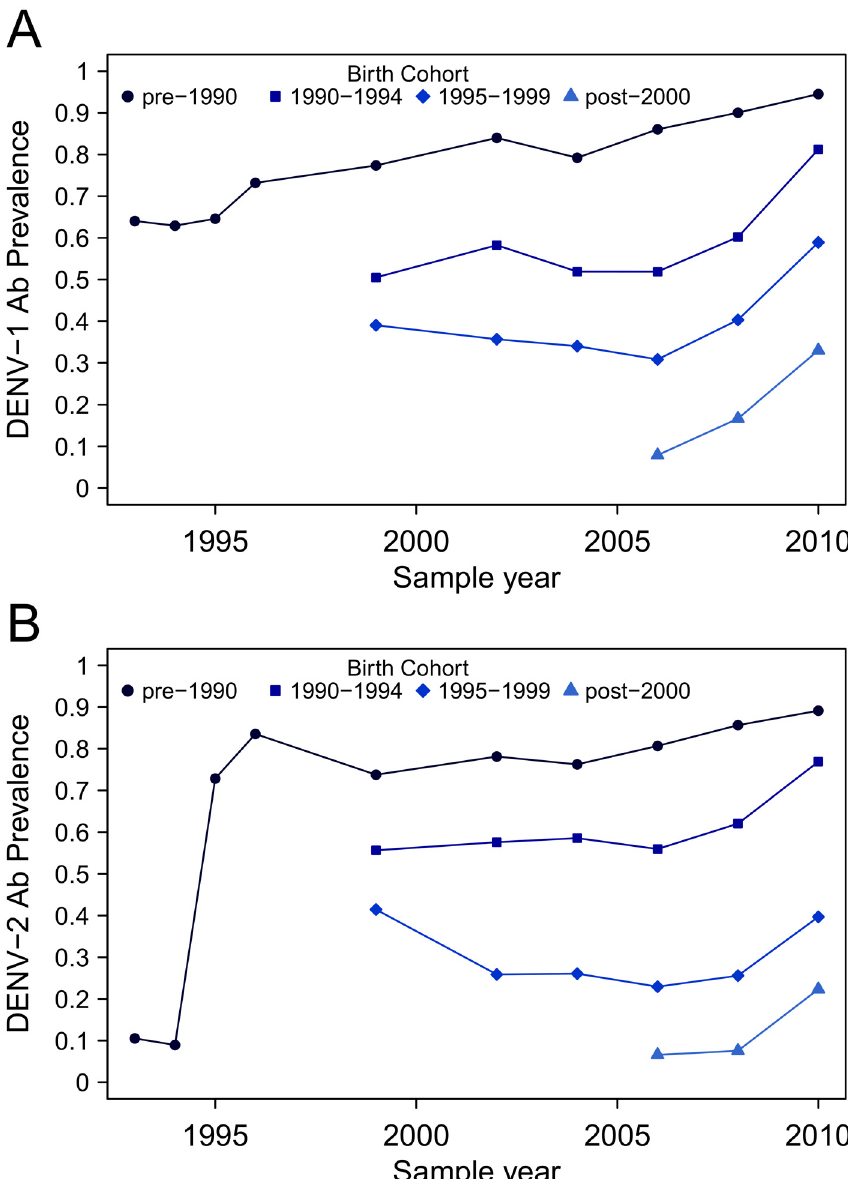
Fig 4. DENV-1 and DENV-2 neutralizing antibody prevalence by year and birth cohort. Samples were collected from longitudinal cohort studies conducted in Iquitos between 1993 and 2010. Panel A: DENV-1 neutralizing antibody prevalence by year, based on birth cohorts. Panel B: DENV-2 neutralizing antibody prevalence by year, based on birth